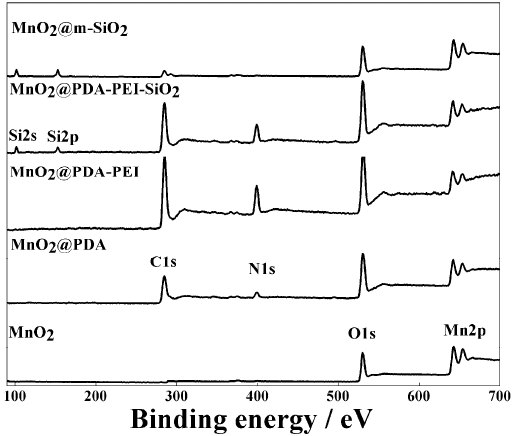
Figure 2. XPS spectra of MnO 2 , MnO 2 @PDA, MnO 2 @PDA ‐ PEI, MnO 2 @PDA ‐ PEI ‐ SiO 2 and MnO 2 @m ‐ SiO 2 .